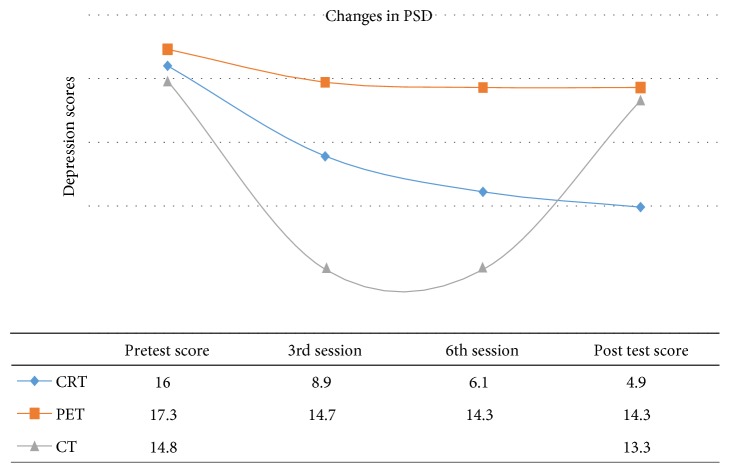
The different levels of depression scores at intervals.